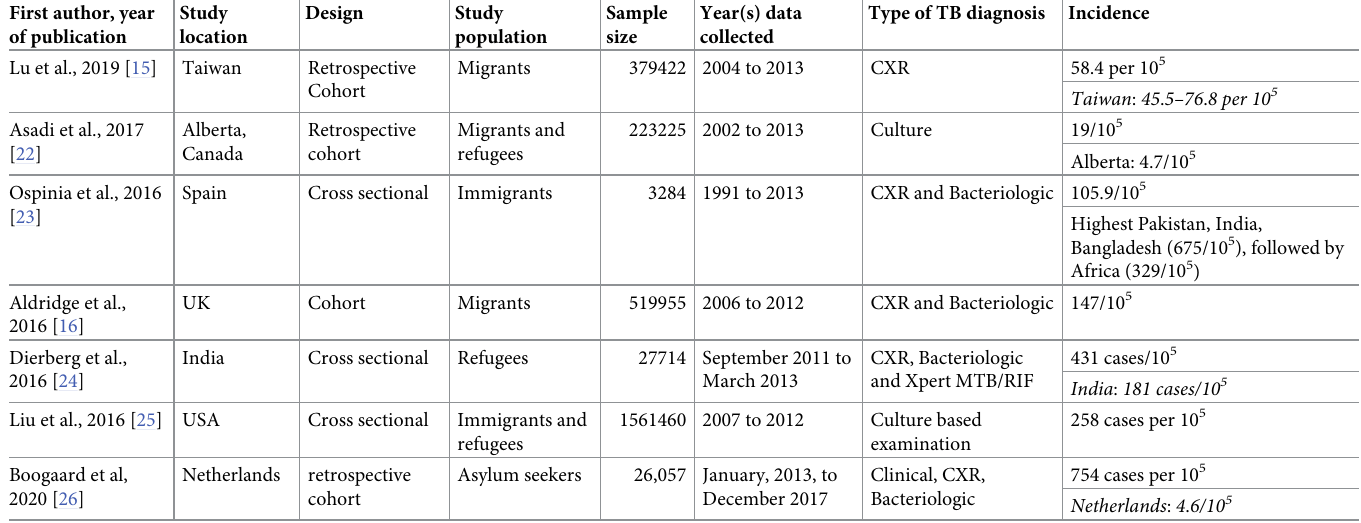
Table 1. Study characteristics and TB Incidence results among the included studies.